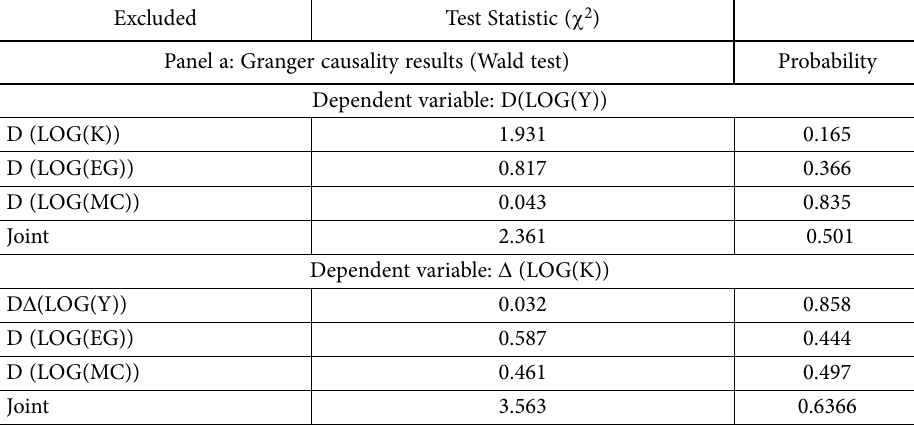
Table 10. Granger causality and lag exclusion test results for the estimated Vector Error-Correction